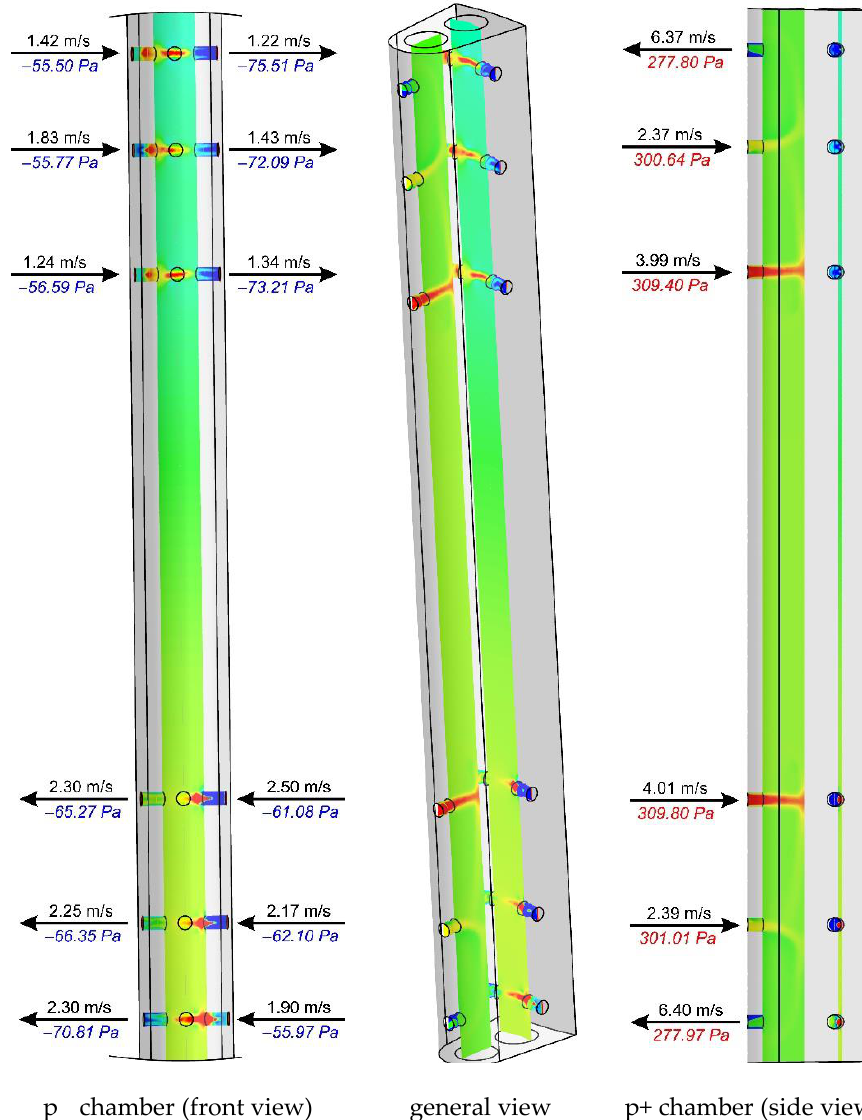
Figure 13. Fluid velocity and total pressure in planes of the bore holes downstream of an elbow (x/D = ∞ ) with curvature R c = 1D.